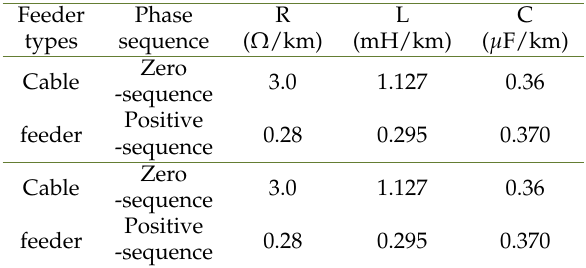
Table 8. Parameters of the